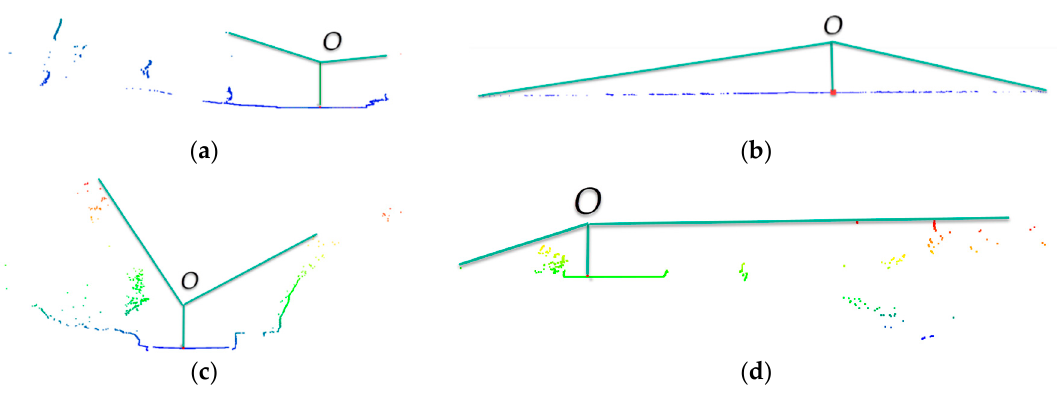
Figure 18. Point distribution of a single scanning line. ( a ) Data 1. ( b ) Data 2. ( c ) Data 3. ( d ) Data 4.